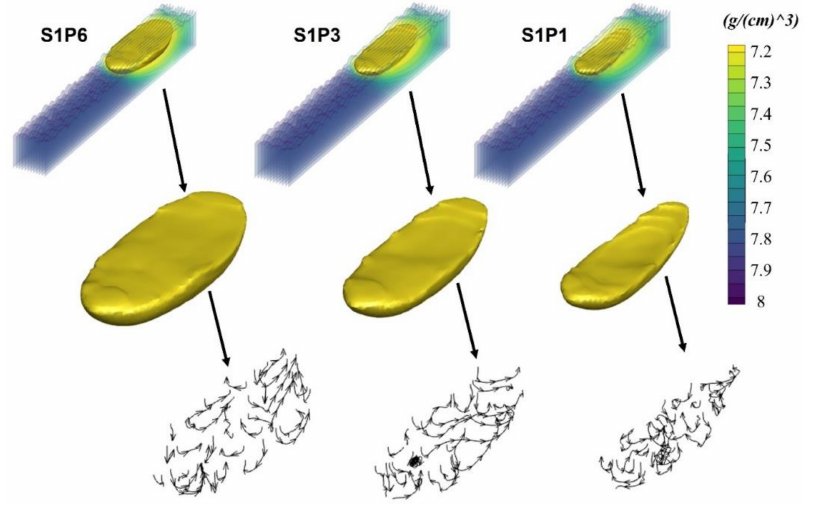
Figure 21. Melt pool profiles in S1P1, S1P3, and S1P6.